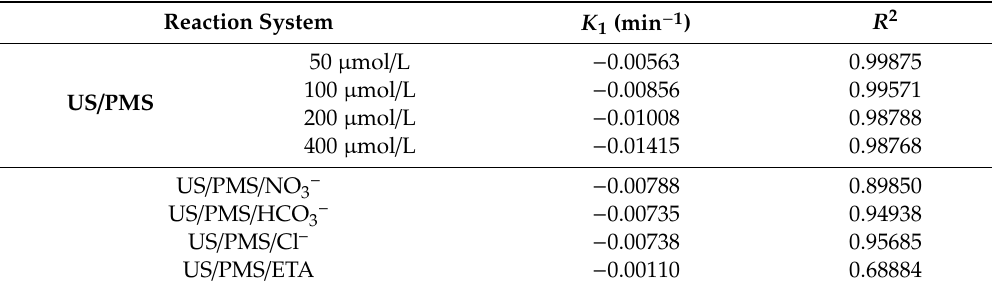
Figure 8. ( a ) The kinetics of quasi - first - order reaction of US/PMS degradation ATZ under different PMS density. ( b ) The kinetics of quasi - first - order reaction of US/PMS degradation ATZ under a different PMS density and different reaction systems. The initial concentration of C 0 is 1.25 μ mol/L. Table 2. The kinetics parameters of US/PMS degradation ATZ.